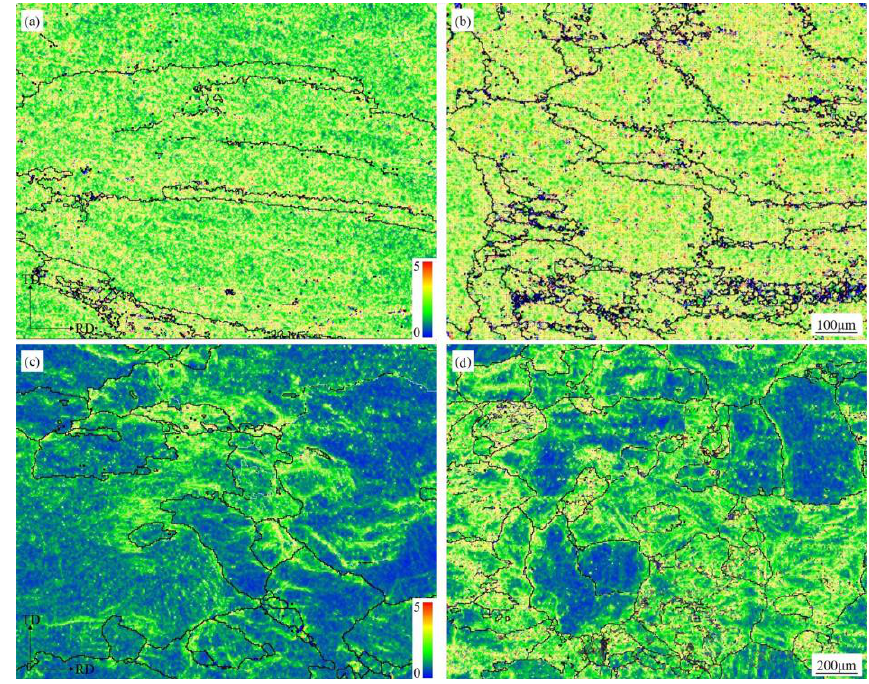
Figure 12. KAM diagrams of the O-state and W-state specimens after a strain of 0.12 at 298 K and 77 K: ( a ) O-state, 298 K; ( b ) O-state, 77 K; ( c ) W-state, 298 K; ( d ) W-state, 77 K.